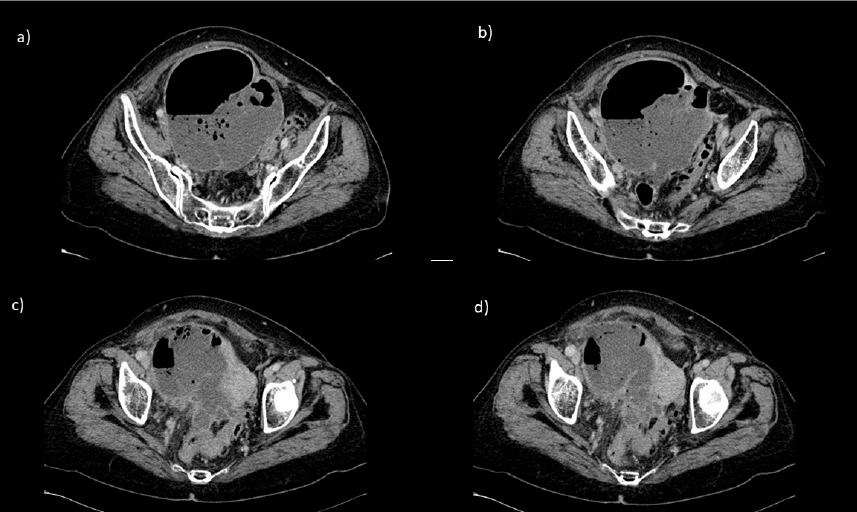
Figure 1. Preoperative CT scan showing the presence of a cervical tumor with extensive necrosis (78 × 43 mm), infiltrating the bladder and without cleavage plan with the rectum. Adjacent to the tumoral mass, a large (multichambered) abscess measuring 124 × 85 × 125 mm was observed which extended to the right parietocolic wall ( a – d